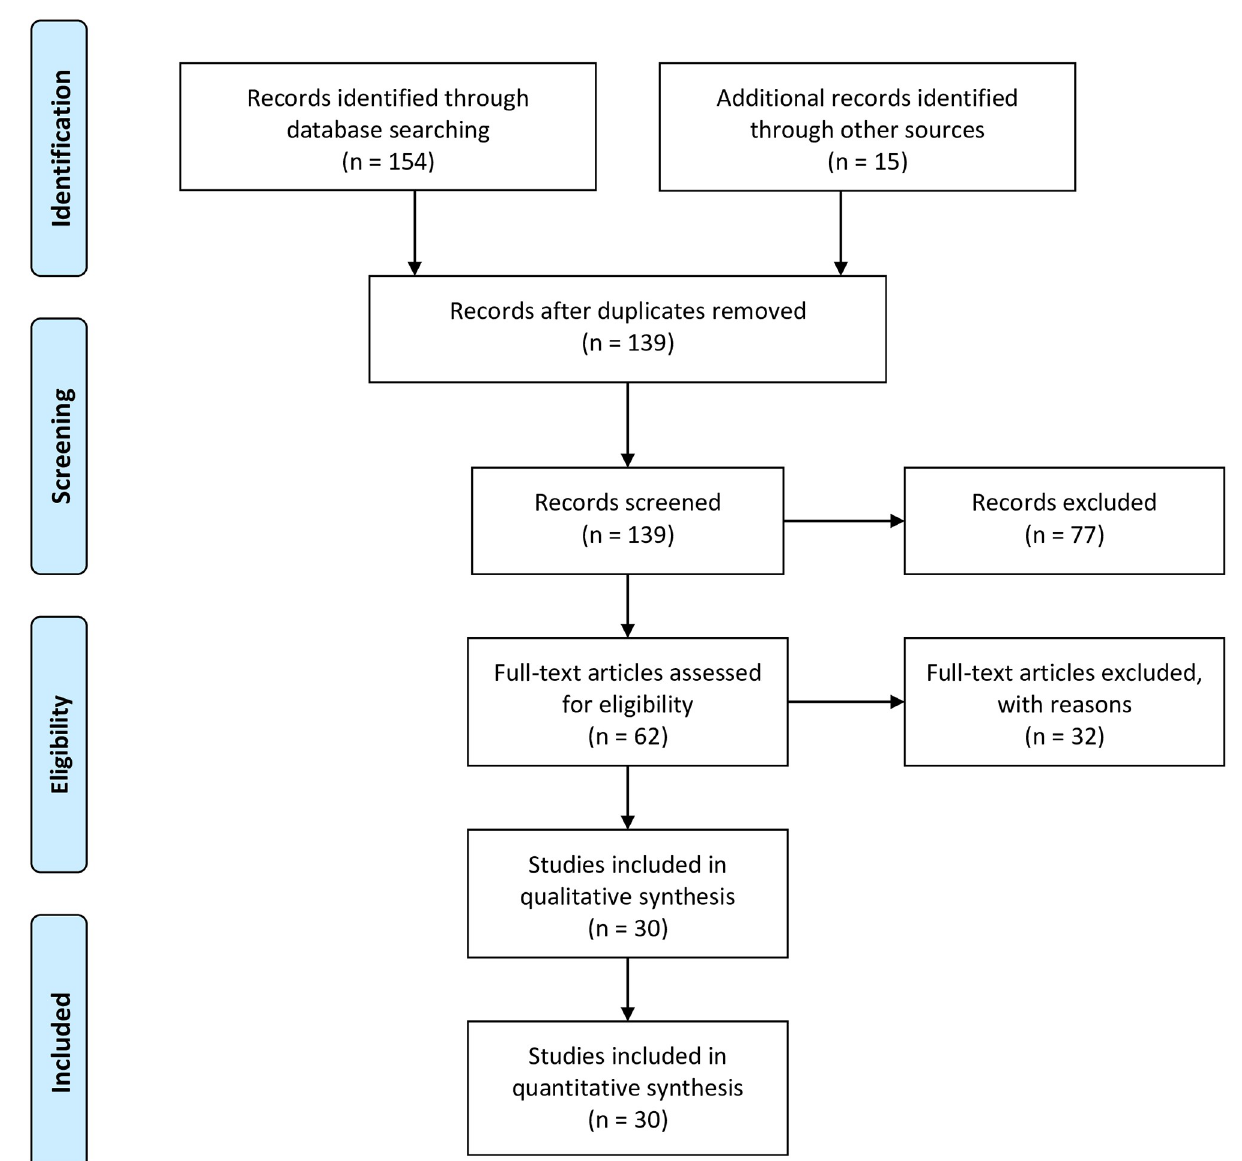
Fig 1. PRISMA flow chart for the identification of the included